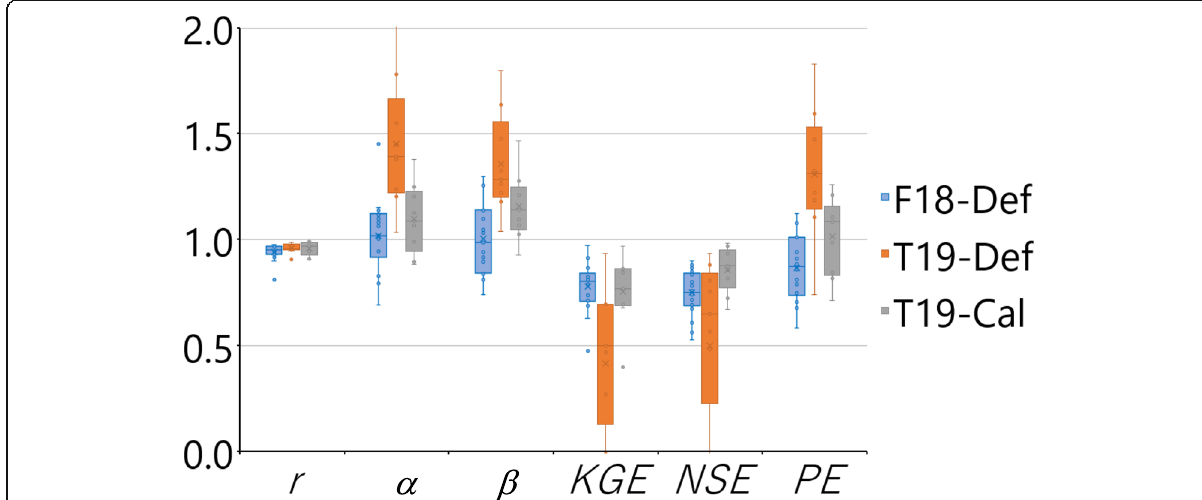
Fig. 2 The box plot of verification metrics of simulated hydrographs evaluated at dam reservoirs. The verification metrics include the correlation coefficient ( r ), the measure of the variability error ( α ) and bias ( β ), the Kling-Gupta efficiency (KGE), the Nash-Sutcliffe efficiency (NSE), and the relative peak error (PE). “ Def ” denotes the default setting of the parameters for F18 and T19, and “ Cal ” stands for the calibrated case considering unsaturated flow component only in the Kanto Region for T19